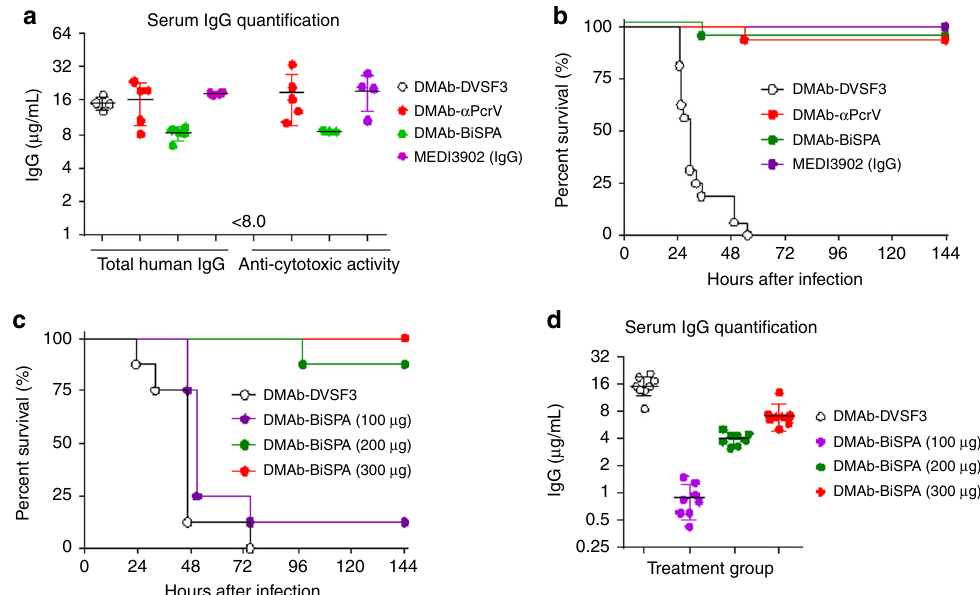
Fig. 4 Functionality and protection by DMAb- α PcrV and DMAb-BiSPA in mice. a BALB/c mice were administered 300 µ g of DMAb- α PcrV, DMAb-BiSPA, or MEDI3902 IgG (2 mg kg − 1 ). n = 5 mice/group. Two animals from the DMAb-BiSPA were below the limit of detection of the anti-cytotoxic activity assay. Antibody levels are representative of DMAb in serum on the day of challenge. b In vivo protection in BALB/c mice following administration of control DMAb-DVSF3 ( black open circles ), DMAb- α PcrV ( red circle ), DMAb-BiSPA ( green circle ) or on day 5 or puri fi ed MEDI3902 mAb ( purple circle ) on day 1 before lethal challenge (data represented is from two independent experiments, n = 8/group/experiment, total n = 16). c Protection with different doses of DMAb-BiSPA: 100 µ g ( purple circle ), 200 µ g ( green circle ), 300 µ g ( red circle ), or DMAb-DVSF3 (control). n = 8 mice/group. d Serum DMAb